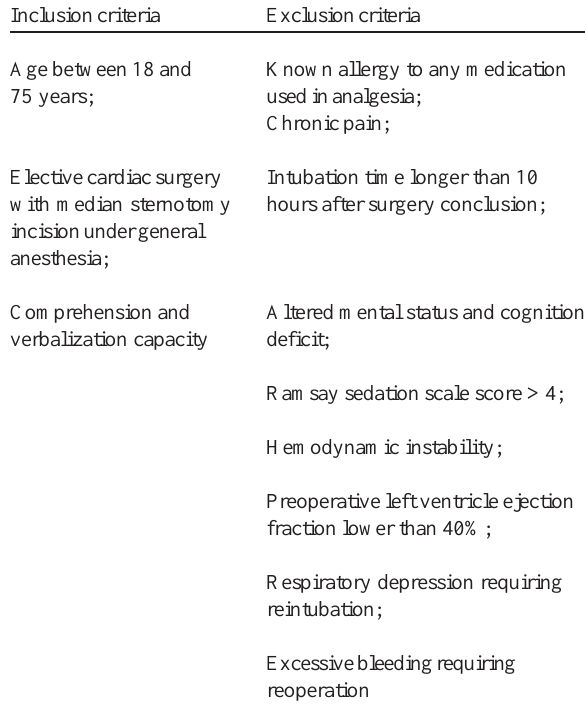
Table 1. Major eligibility